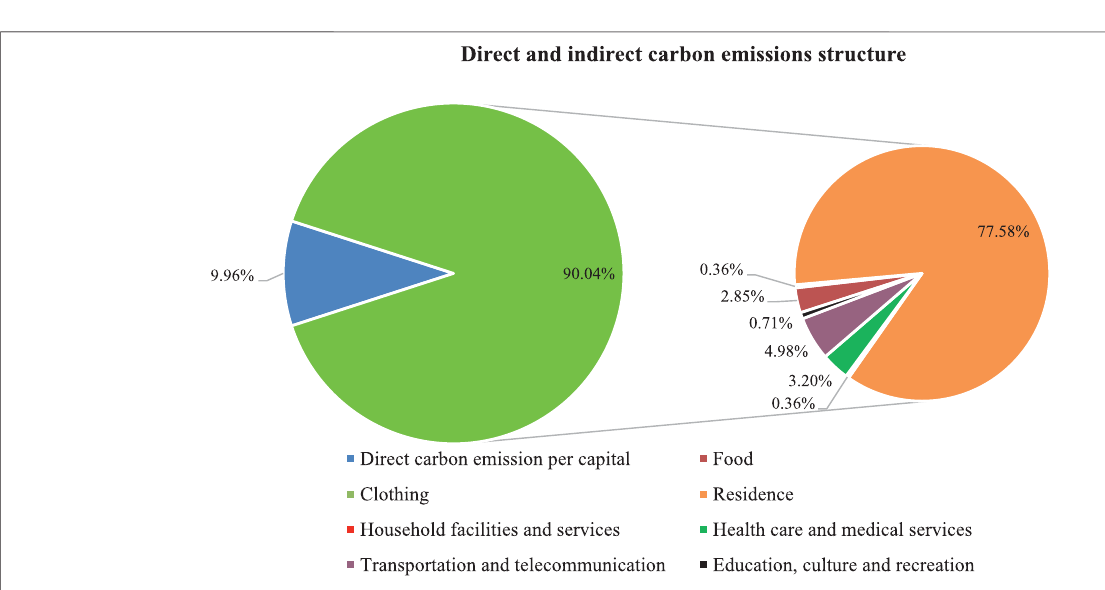
Frontiers in Earth Science |